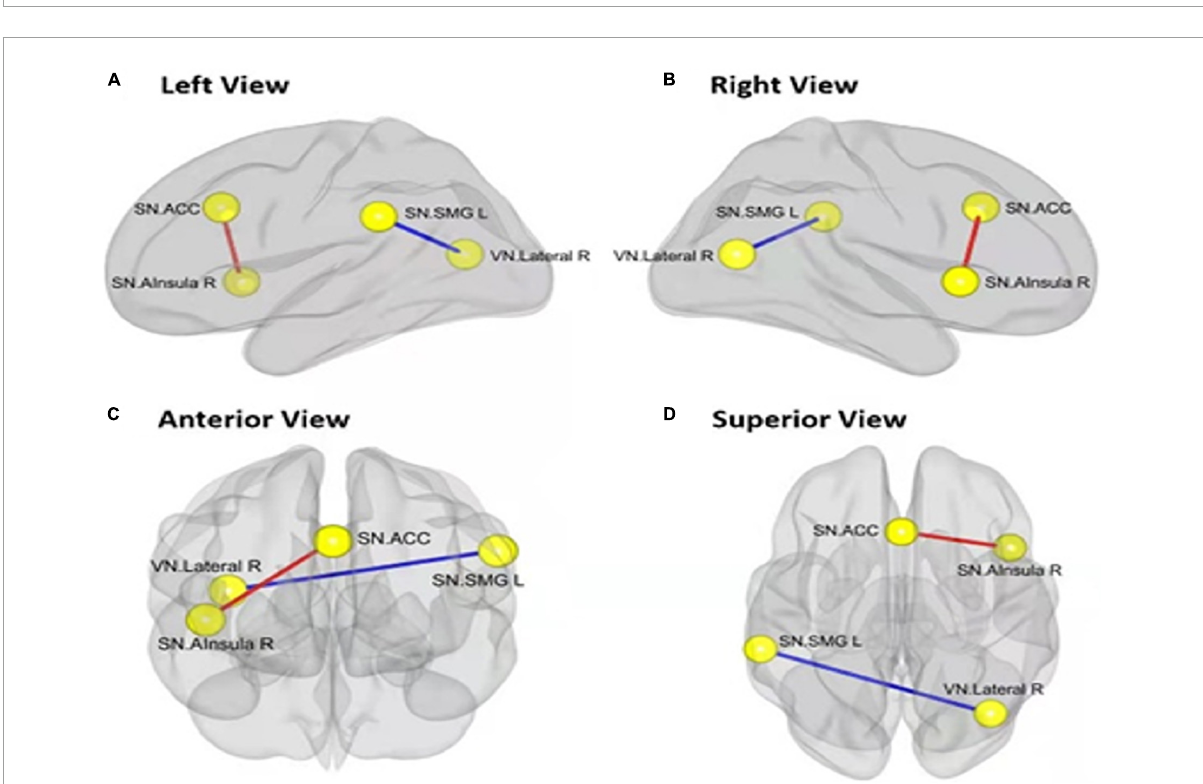
FIGURE6 Alerted ROI-to-ROI functional connectivity of networks contrasting in rested wakefulness (RW) vs. total sleep deprivation (TSD) scans: Comparing to RW scan, functional connectivity of ACC-Alsula (R) [within salience network (SN)] is higher (the red line), and functional connectivity of SMG(L)-Lateral(R) (SN-VN) is lower (the blue line). All the results are shown at panels (A) left view, (B) right view, (C) anterior view, (D) superior view. (FDR set wise corrected for all comparisons across the entire network). ROI, region of interest; ACC, anterior cingulate cortex; SMG(L), left supramarginal gyrus; VN, visual network. * p < 0.05, ** p < 0.01, *** p <